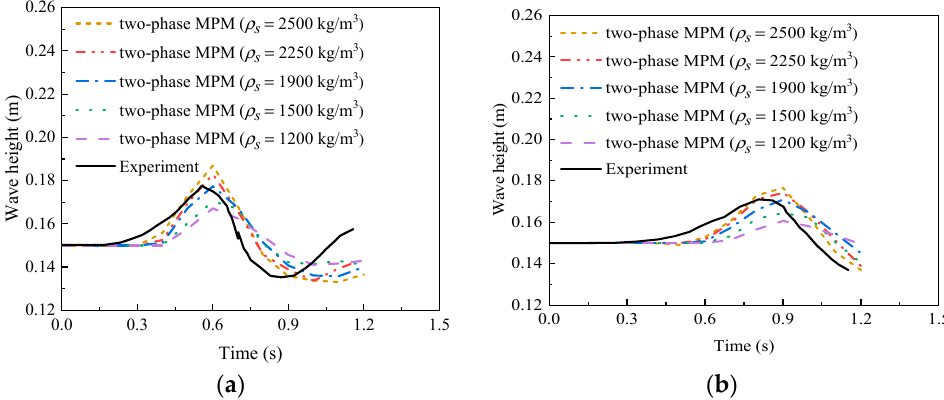
Figure 11. Influence of density of sliding sand: time history curve of the free water surface at two different locations: ( a ) X1 = − 0.3 m; ( b ) X2 = − 0.6 m. In addition, the effect of elasticity modulus of sliding sand is investigated. Five elasticity modulus (E = 5, 10, 20, 30, and 40 MPa) are used in the simulation, and other conditions remain unchanged. Figure 12 displays the change in free water surface height over time at locations X1 and X2 for different elasticity modulus and displays the correlation of elasticity modulus. The numerical results show that the impact of elasticity modulus on the water wave is almost negligible for slow landslides.